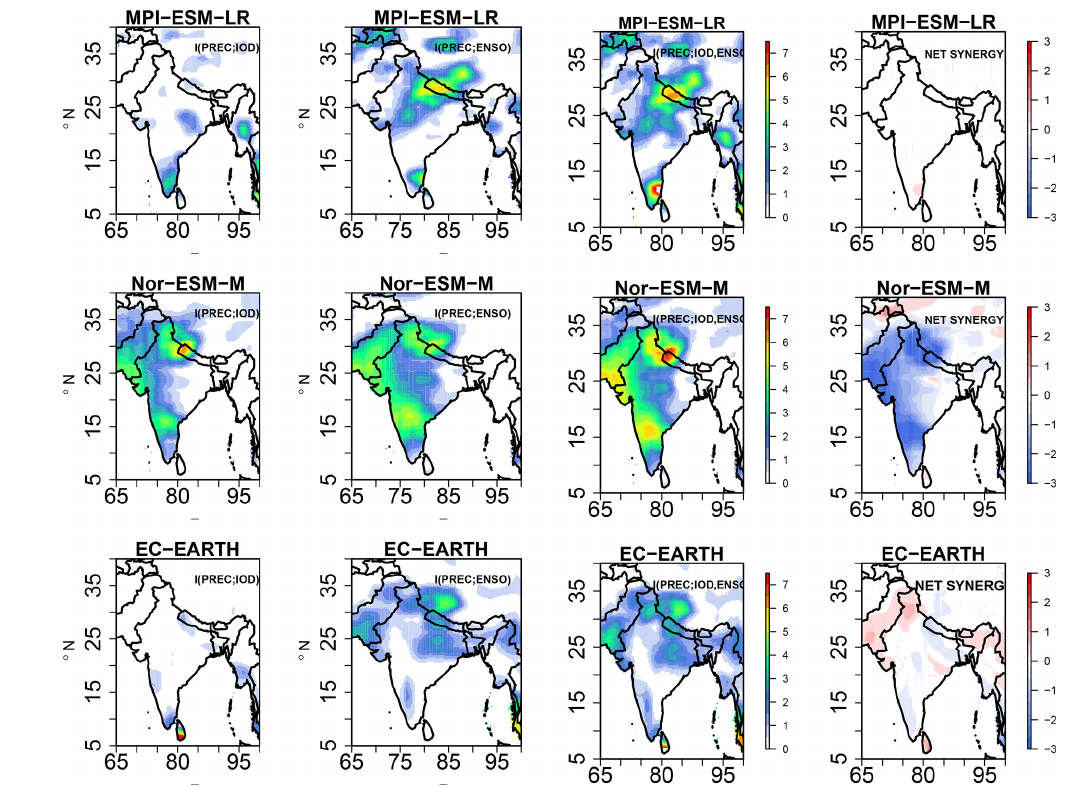
Figure 9. Information exchange from I (PREC; IOD), I (PREC; ENSO), two-source information exchange I (PREC; ENSO, IOD), and net synergy × 10 − 2 nats for the GCM simulations MPI-ESM-LR, Nor-ESM-M, and EC-EARTH for JJAS (1951-2005). Only significant values at 95% confidence intervals are